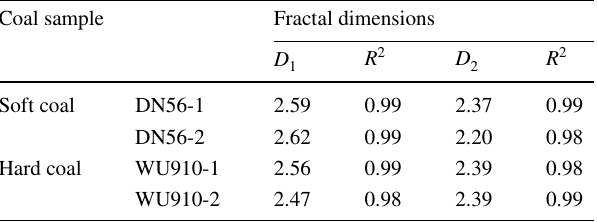
Table 4 Pore fractal dimensions of coal samples Coal sample Fractal